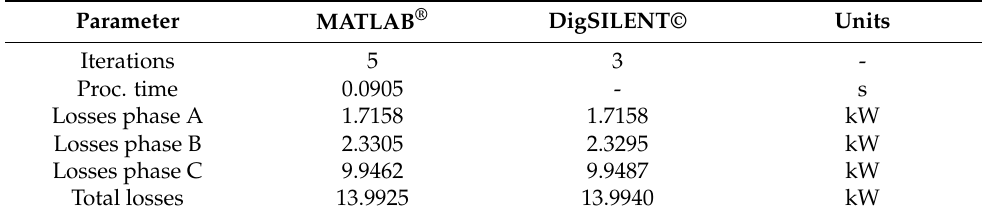
Table 5. Numerical results for the 8-node test system.